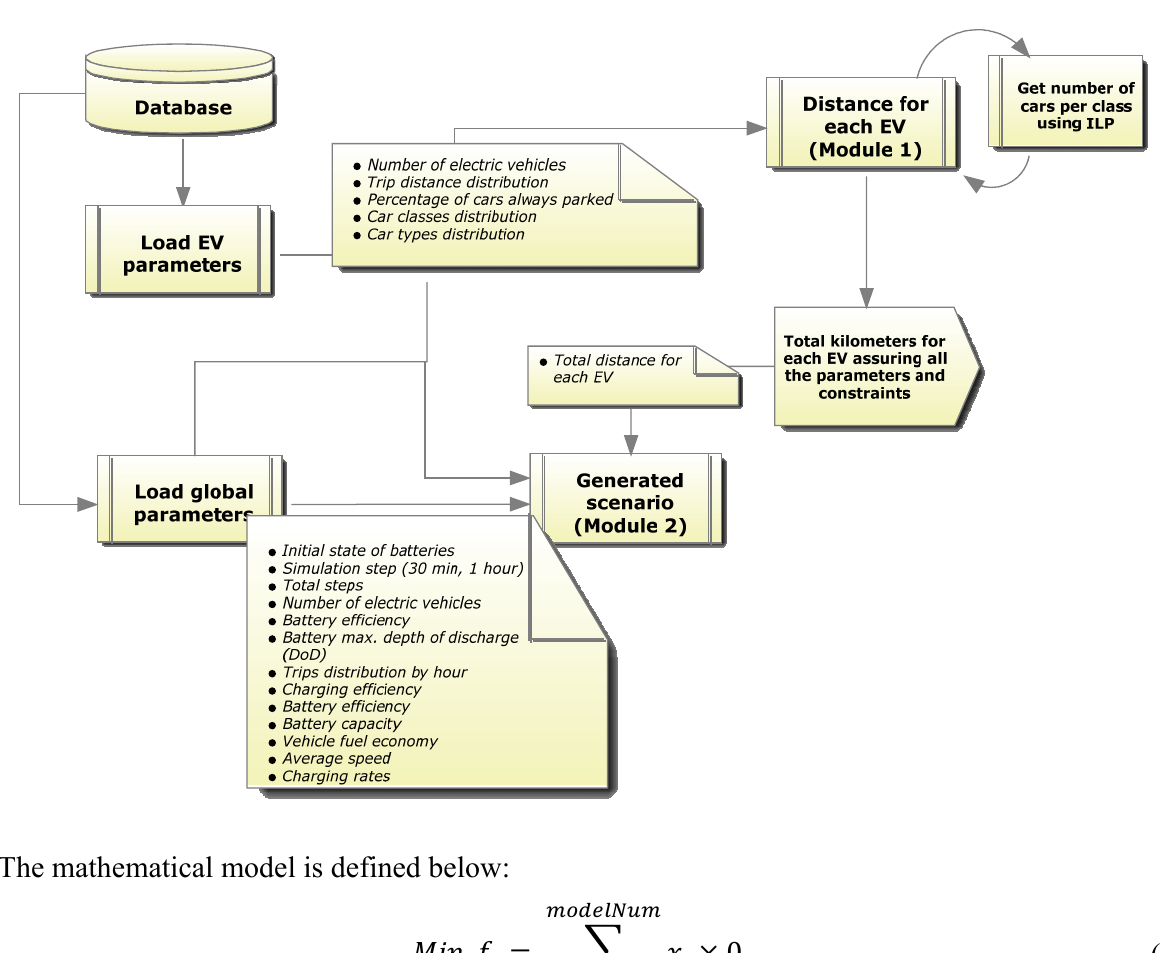
Figure 5. EVeSSi